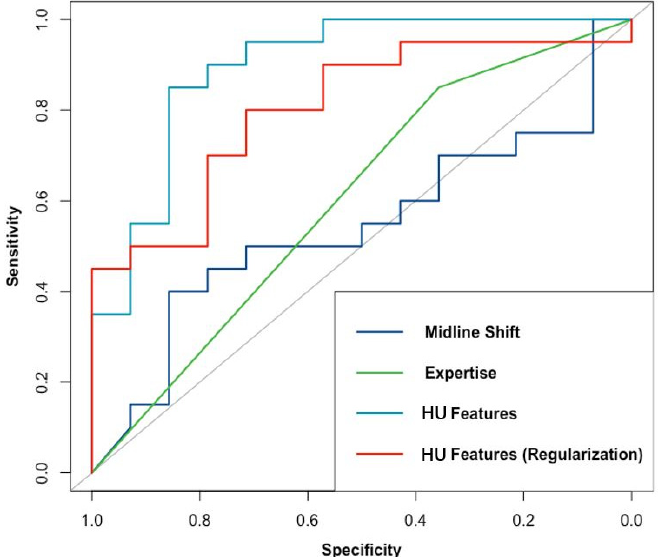
Figure 4. Performance of models based on HU features (original and regularized), midline shift, and clinical expertise in discriminating intracranial hypertension in unilateral TBI patients; the AUCs for these models were 0.90, 0.80, 0.54, and 0.60, respectively.